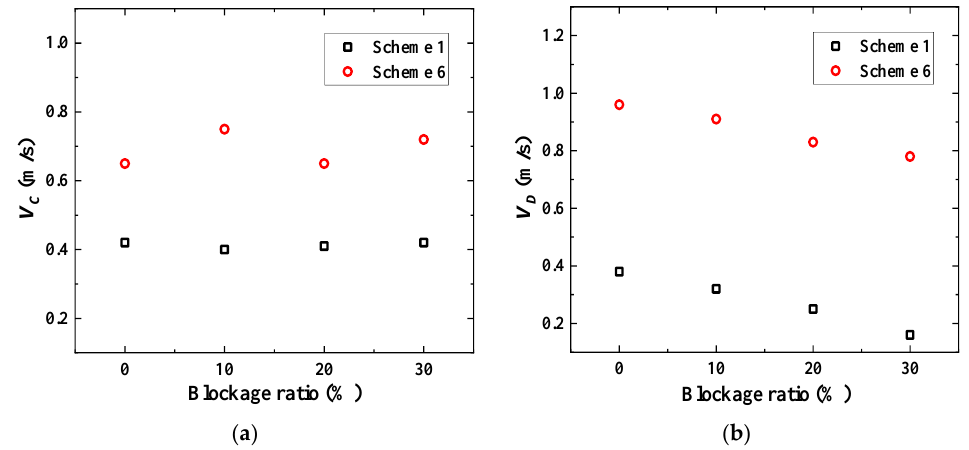
Figure 4. Variation in longitudinal ventilation velocities with different blockage ratios under the same velocity scheme: ( a ) ramp C velocity; ( b ) ramp D velocity. Table 3. Longitudinal ventilation velocity measured values of ramp C and ramp D. Test NO.